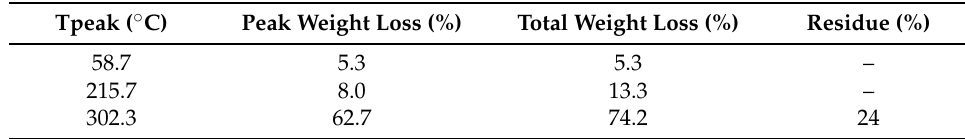
Table 2. Thermal parameter for whey protein isolate.